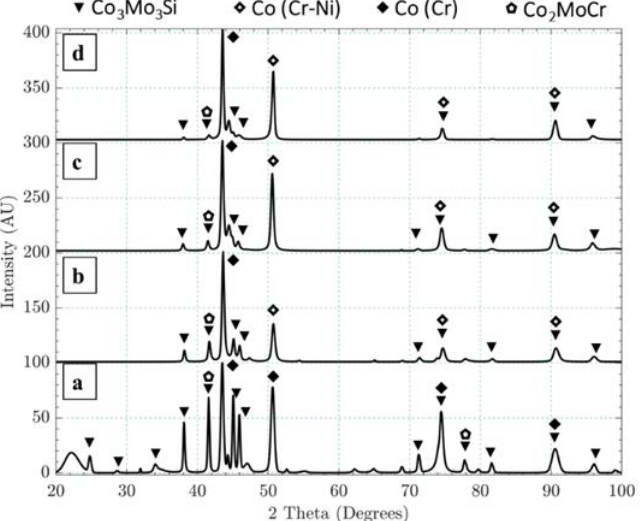
Figure 4. XRD results of as processed samples. ( a ) 100% T800, ( b ) T800 + 20% NiCr, ( c ) T800 + 30% NiCr, and ( d ) T800 + 40% NiCr.